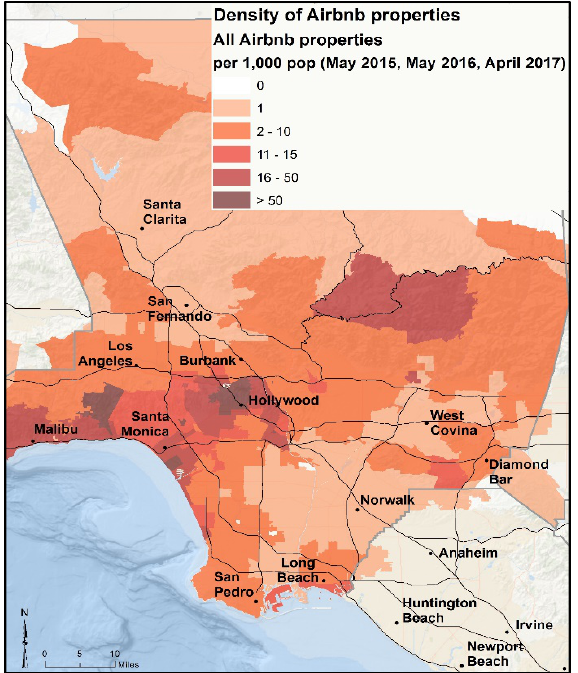
Figure 2. Zip Code Density of All Airbnb Properties, Greater Los Angeles, May 2015, May 2016, and April 2017